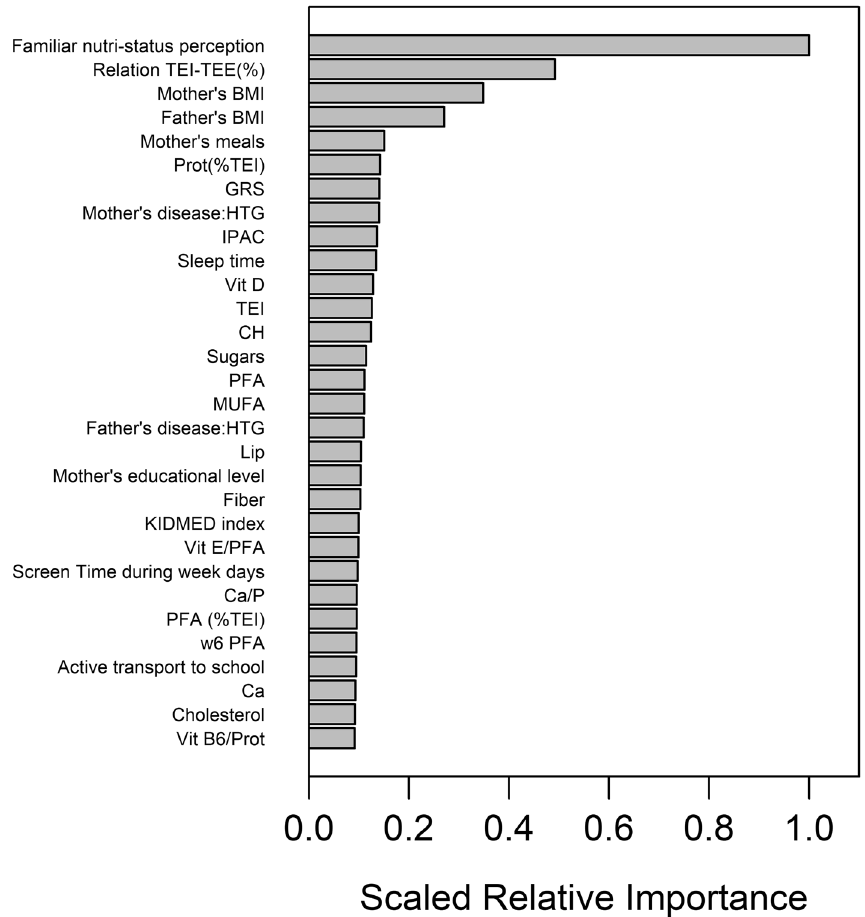
Figure 5. Consensus Variable Importance plot of the top-30 predictor variables for the GENYAL sample, after the RF & GBM models to predict childhood